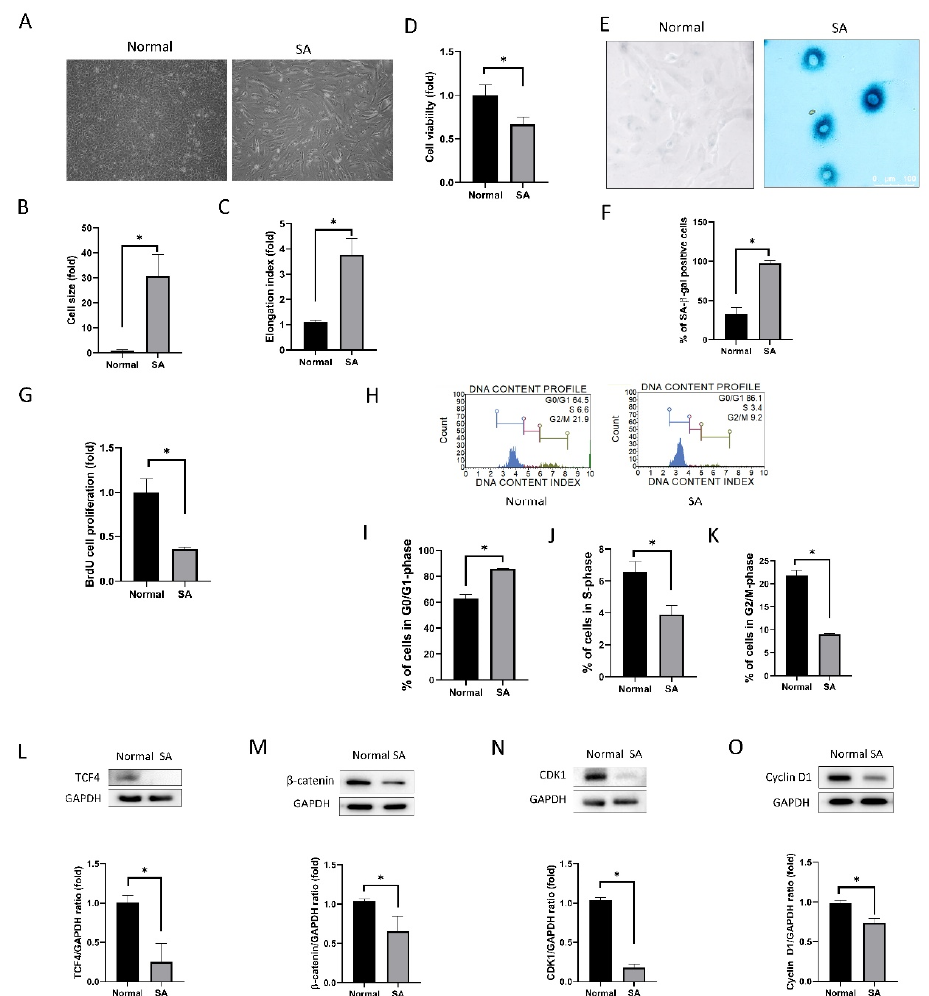
Figure 1. Cell shape, senescence-associated (SA)- β –gal assay, proliferation, and cell cycle. ( A ) Inverted microscopy image showing cell shape in normal and SA groups. ( B ) Comparison of cell size between normal and SA groups. ( C ) Elongation index for normal and SA groups is shown. ( D ) Comparison of cell viability between normal and SA groups. ( E , F ) Evaluation of senescence in normal and SA groups. The proportion of SA- β –gal stained cells was higher in the SA group. ( G ) Cell proliferation rate was measured by bromodeoxyuridine (BrdU) incorporation assay. ( H ) Cell cycle analysis was performed. ( I – K ) The proportion of cells in the G0/G1, S and G2/M phase are shown. ( L ) TCF4 expression was decreased in the SA group. ( M ) β-catenin expression was decreased in the SA group. ( N ) Cyclin dependent kinase 1 (CDK1) expression was decreased in the SA group. ( O ) Cyclin D1 expression was not different between the normal and SA groups. All experiments were conducted in triplicate or quadruplicate. * for p < 0.05 using independent t -test.